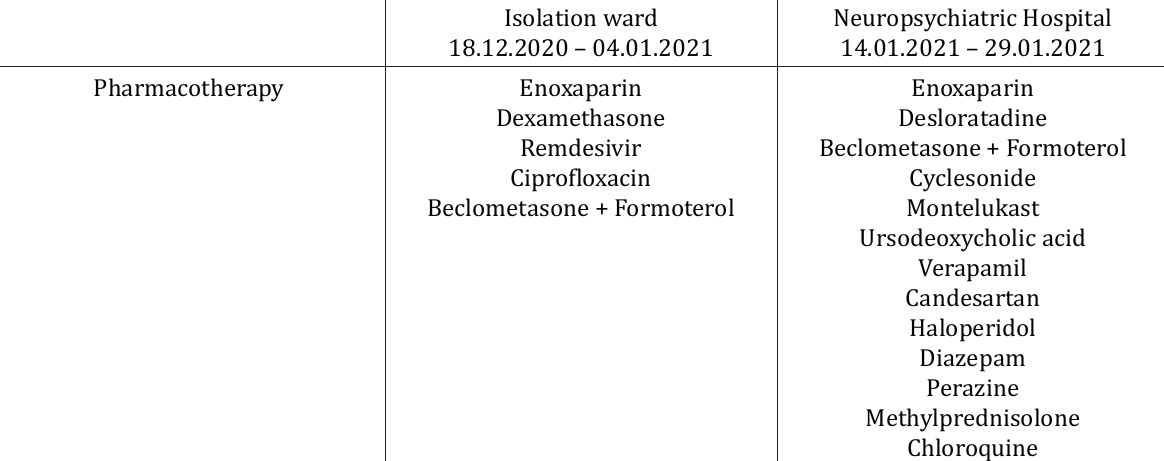
Table 1. Pharmacotherapy applied in a patient during the hospitalization in isolation ward and the Neuropsychiatric